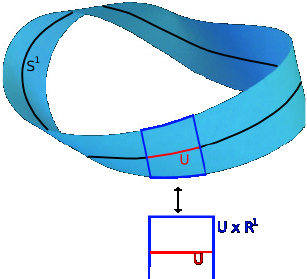
Figure A1. Vector Bundle Illustration. (By Jakob.scholbach at English Wikipedia, CC BY-SA 3.0, Figure A1. Vector bundle illustration (by Jakob.scholbach at English Wikipedia, CC BY-SA 3.0, https: https://commons.wikimedia.org/w/index.php?curid=6082417)